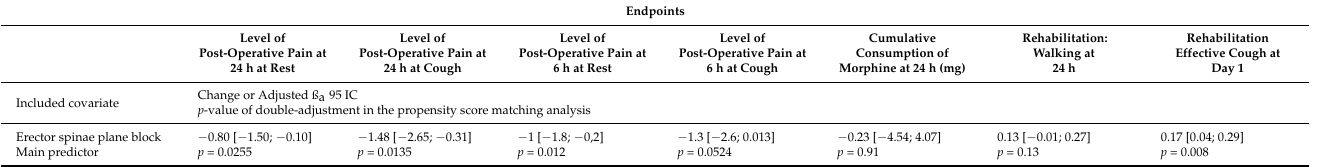
Table 2. Propensity score